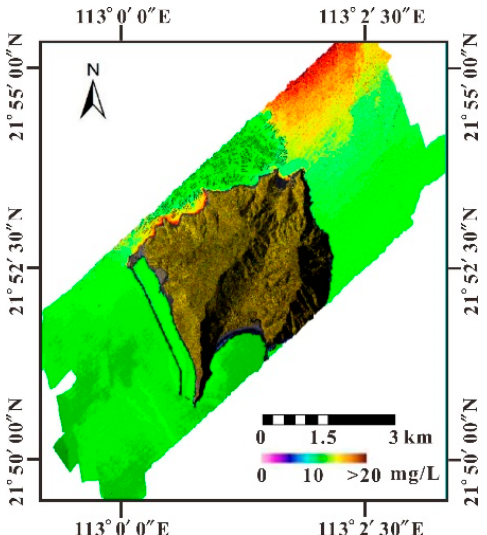
Figure 6. Distribution of SSC inversed by CASI data in the sea area around Dajin Island. According to MODIS/SSC (Figure 7), the SSC in the Pearl River Estuary varies from 0.03–20.45 mg/L, which is consistent with previous studies [42,43]. A high SSC distributes along the coastline and exhibits zonal decrease with distance offshore from the northeast to the southwest. Moreover, MODIS/SSC indicated that the unique geographical location and hydrodynamics are the main factors impacting the SSC distribution around Dajin Island. Once the land-sourced SSC enters the sea area of the northern Dajin Island, the SSC along the west bank of the Huangmao Sea becomes significantly higher than that along the east bank due to the deflection force of the geostrophic force. The obstruction caused by Dajin Island leads to an obvious branching phenomenon north of the island, which results in a higher SSC along two sides of the island. The static hydrodynamic environment that developed north of the island and that is characterized by a low SSC (and high transparency) is suitable for aquaculture. Generally, SSCs gradually decrease to the southeast and southwest of Dajin